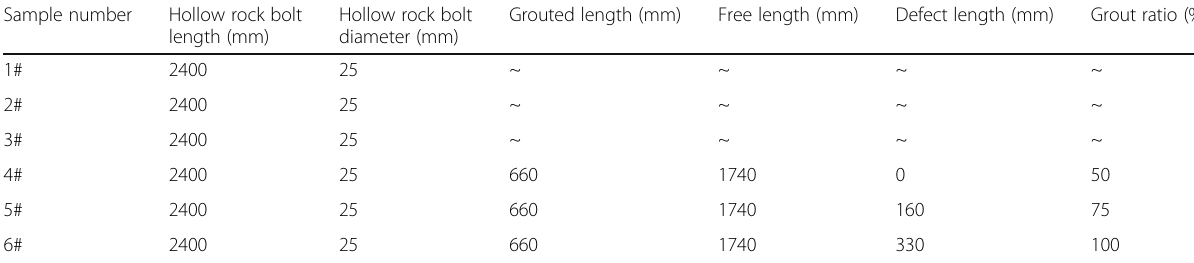
Table 1 The geometric parameters of the samples Sample number